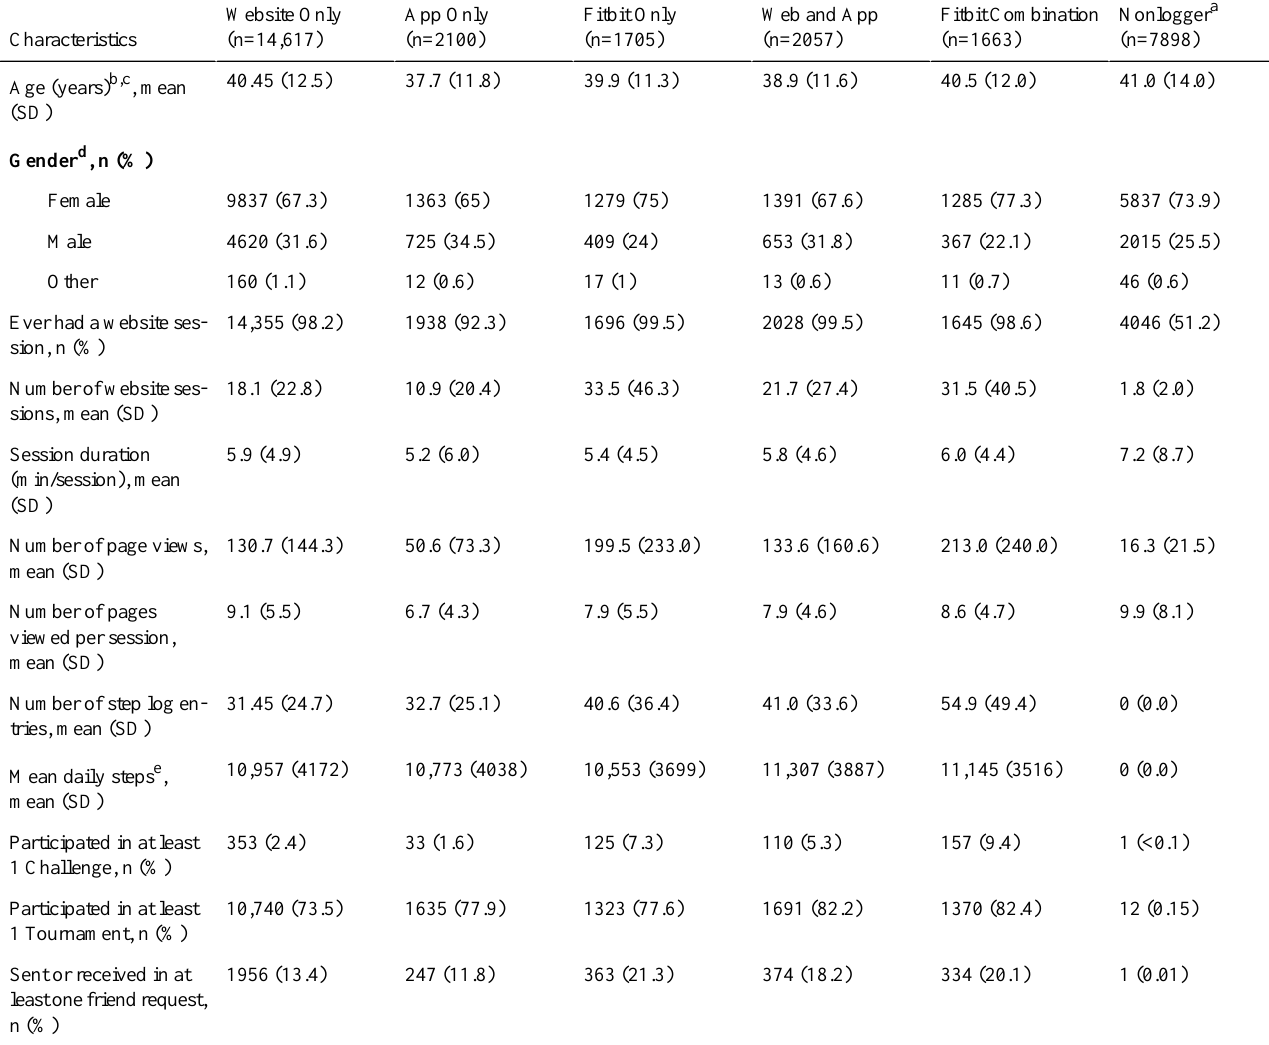
Table 1. Descriptive summary of new users—by user group—of the 10,000 Steps program registered between January 1 and November 30, 2018